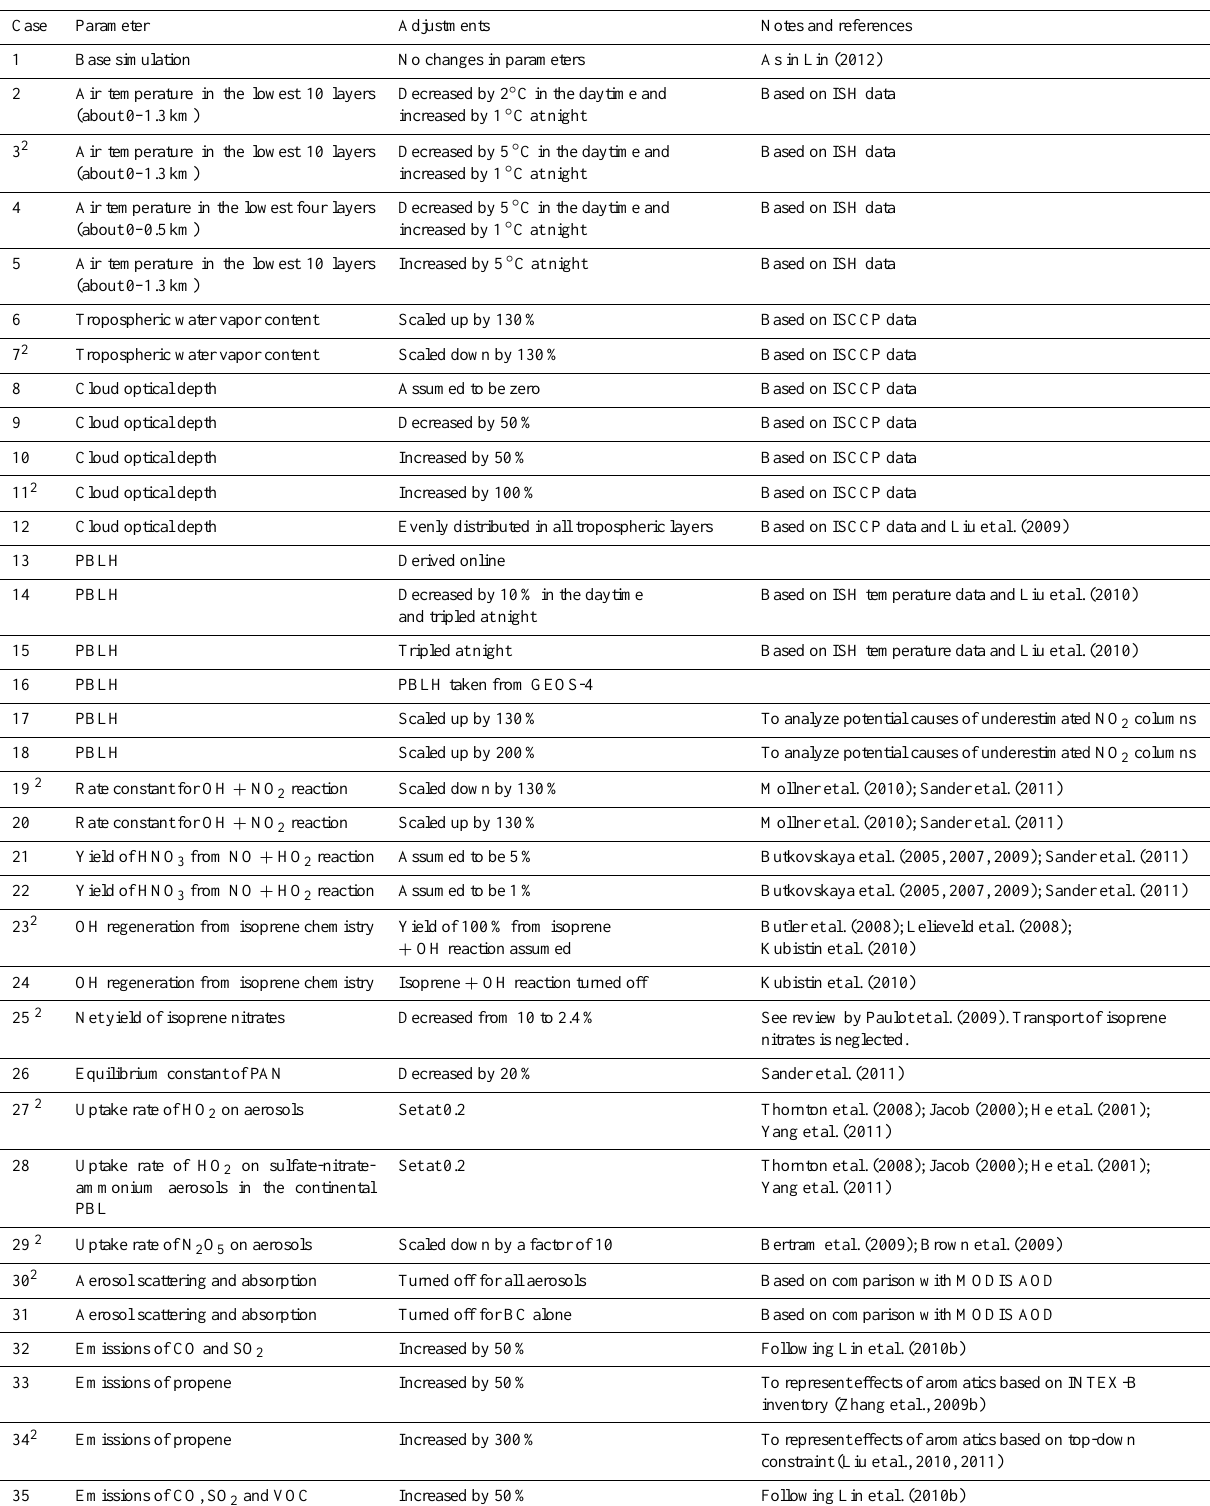
Table 1. Sensitivity simulations by adjusting model meteorological or chemical parameters 1